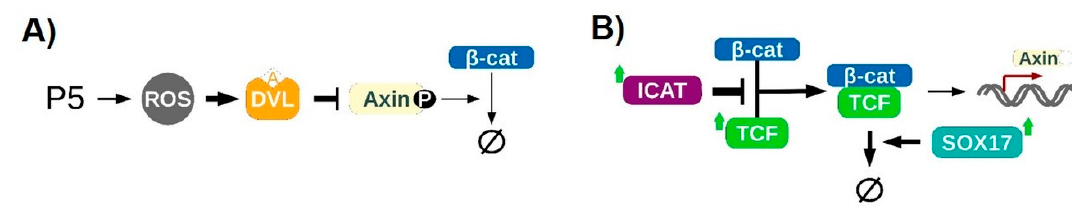
Figure 9. Simplified representation of ( A ) the signal pathway from reactive oxygen species (ROS) production (P5 induced) to eventual accumulation of β -catenin. Briefly, MG-63s respond to P5 with increased production of ROS, which inhibit AXIN-mediated degradation of β -catenin through Dishevelled (DVL). The width of the lines is proportional to the reaction kinetics (flux) through each reaction compared to Ref. Note that β -catenin accumulation typically induces increased AXIN synthesis. However, this is attenuated by the specific expression pattern, as shown in ( B ) the transcriptional regulation of β -catenin target gene expression on P5. A briefly elevated gene expression of T-cell specific transcription factor 4 ( TCF4 ), inhibitor of β -catenin and TCF-4 (ICAT) and SRY-box transcription factor 17 ( SOX17 ) leads to attenuated formation of the TCF/ β -catenin complex (by ICAT) and proteosomal degradation of the β -catenin complex (by SOX17). The β -catenin target gene expression is thereby kept level despite its intracellular aggregation. The width of the lines is proportional to the reaction kinetics (flux) through each reaction compared to Ref.